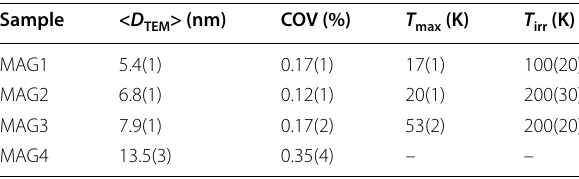
increase below T max (according to a Curie-like behavior) for MAG1 and MAG2, a slower increase (slope decreas- ing with decreasing temperature) for MAG3, and a very Table 1 Average particles diameter <D > , polydispersity TEM weak temperature dependence range for MAG4 without evaluated as the coefficient of variation (COV), the temperature showing a maximum in ZFC magnetization. This sug- corresponding to the maximum of the ZFC curve ( T ), and the max irreversible temperature between ZFC and FC curves ( T ) are gests a change from non-interacting or weakly interact- irr reported ing particles’ behavior (for MAG1 and MAG2) to that of moderately interacting particles (for MAG3), to collec- Sample tive magnetic behavior, where interparticle interactions are dominant (for MAG4). Interparticle interactions pro- vide an additional contribution to the effective magnetic anisotropy and then to the T max and T B values [55]. The magnetization versus field M(H) curves meas- ured at 5 K (Fig. 3a, b and data in Table 2) show For MAG4 these two temperatures are above 300 K, the maximum value employed for the measurements